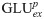
Kinetic rates describing the transition between major CLC-2 conformations, as a function of GLUex protonation.Note that the size of each node is proportional to its equilibrium population (larger denotes a lower free energy), and the weight of each arrow is proportional to the speed of the kinetic transition (heavier weight denotes a faster rate). Additionally, it is possible that there exist transitions occurring over timescales longer than what was sampled in our datasets (which likely underlies the lack of an observed transition from Coi to U). As identified by the thermodynamic analysis, the U conformational state exists only for the GLUexp model. Both the GLUex and GLUexp models show similar rates describing Coi ↔ Co and Co ↔ O. However, in the case of GLUexp, state U may transition forward to any other state.